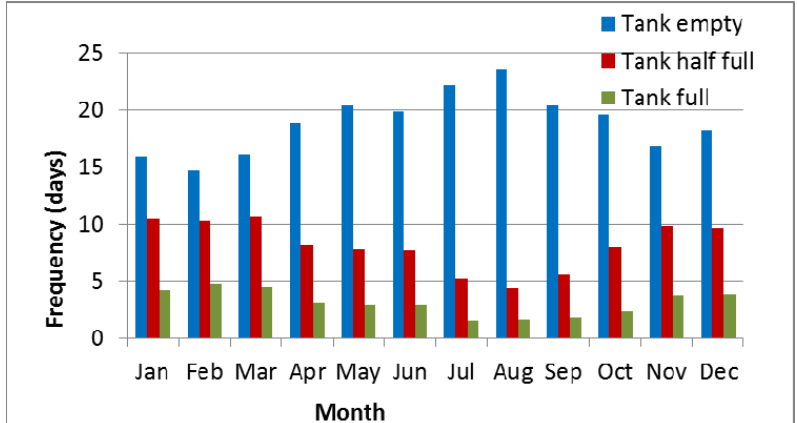
Figure 10. Frequency of tank being full, half-full and empty at Campbelltown (considering the daily rainfall data of all the years on